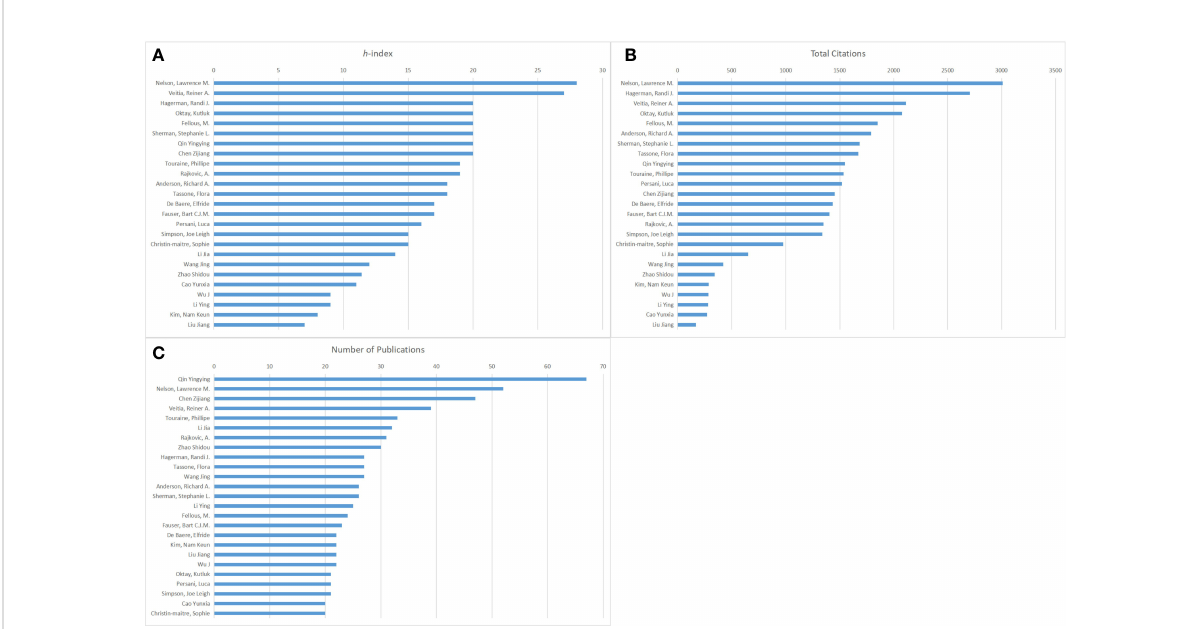
FIGURE 3 The publishing performance of authors. (A) The top 25 authors based on the h -index from 2000 to 2021. (B) The top 25 authors based on total citations from 2000 to 2021. (C) The top 25 authors based on the number of publications from 2000 to